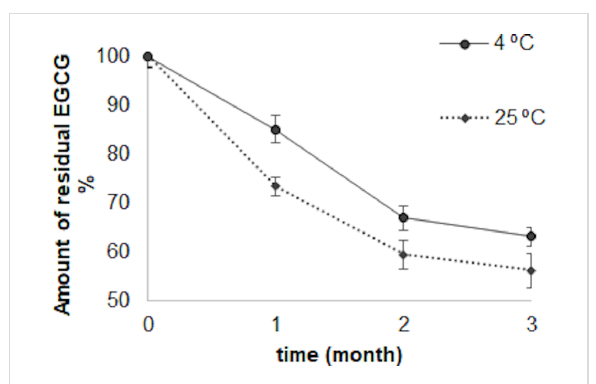
Figure 4: Degradation of EGCG in suspended ETHs at 4 and 25 °C (error bars represent standard deviations, n =